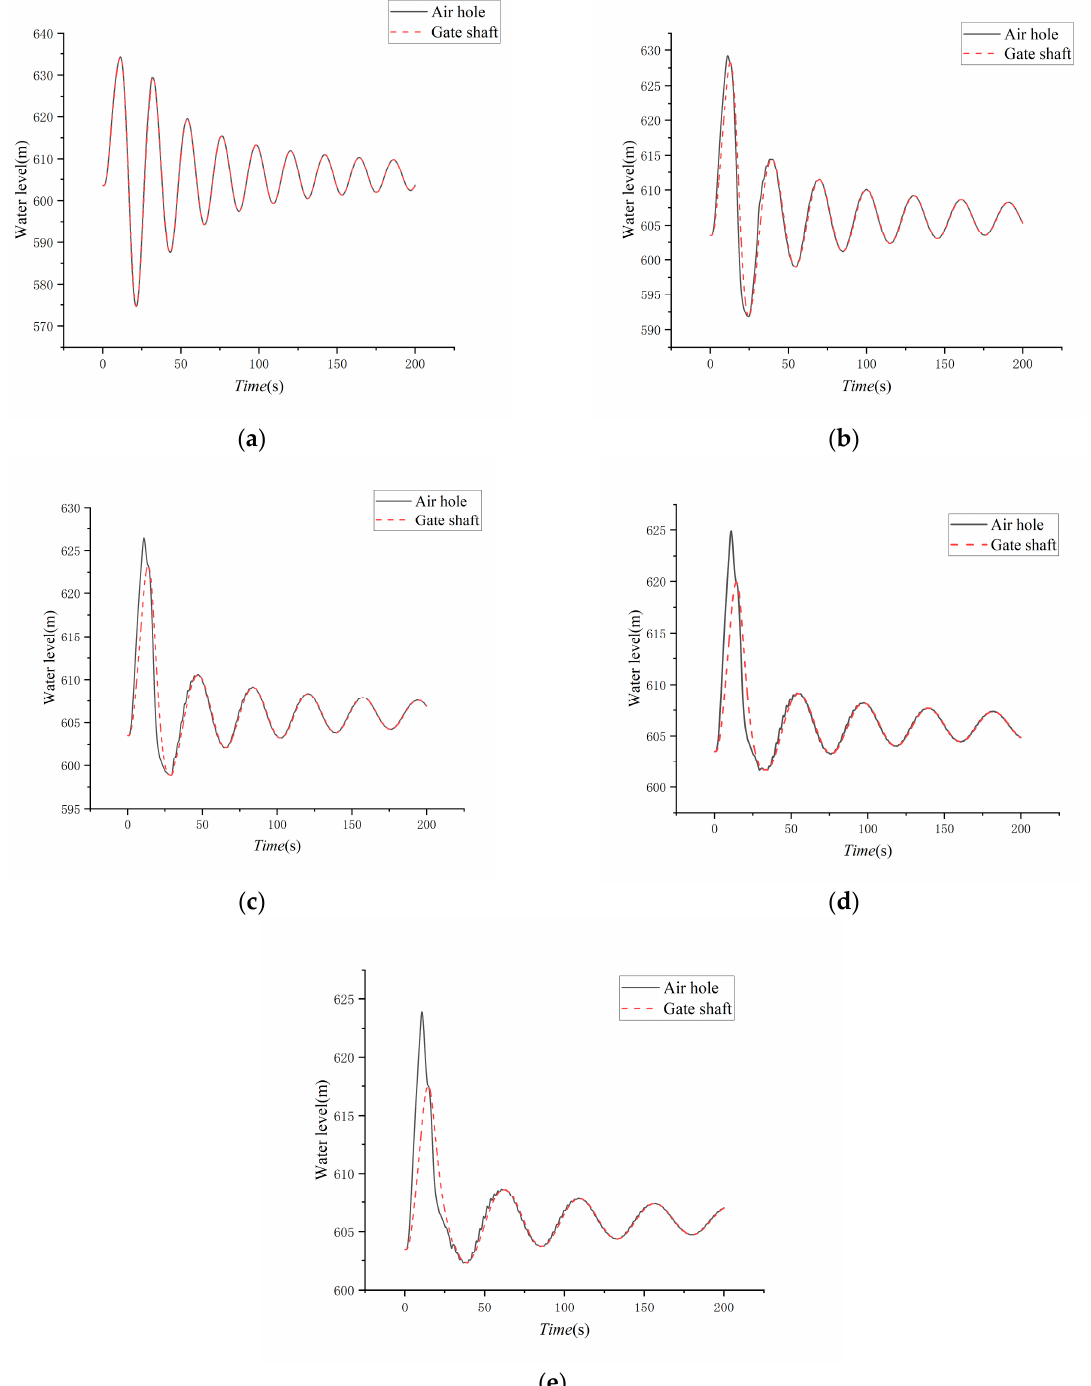
Figure 6. Water level of gate shaft and air hole (different upper chamber areas of gate shaft): ( a )